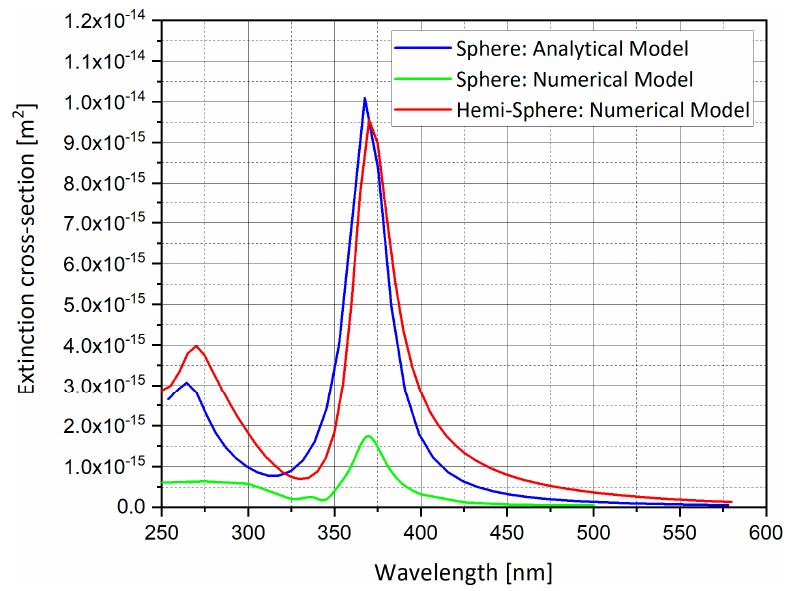
Figure 4. Analytical and numerical model comparison for extinction cross-section of silver (Ag) sphere and hemi-sphere.